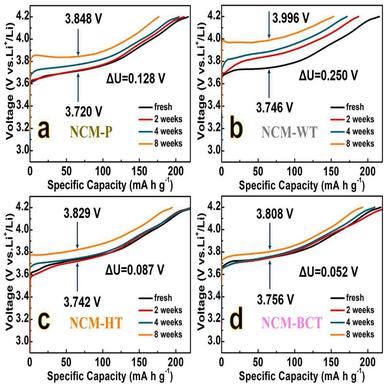
Charging profile comparison of LiNi0.8Co0.1Mn0.1O2 cathode materials with various treatments: (a) NCM-P, (b) NCM-WT, (c) NCM-HT and (d) NCM-BCT, respectively.